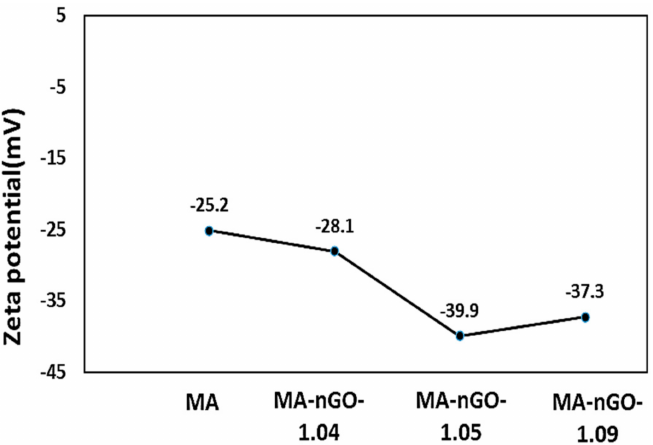
Figure 5. MA-nGO composite particles electrical zeta potential analysis in the Malvern